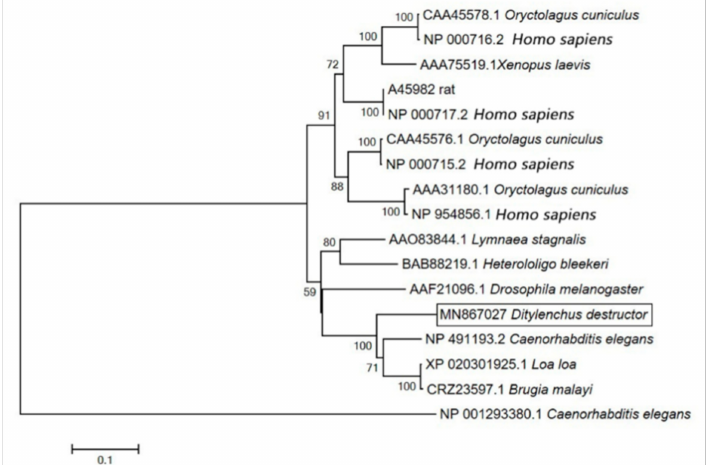
Figure 2. Molecular phylogenetic analysis of DdCa v β via the neighbor-joining method. The species that were used in phylogenetic tree construction are summarized in Table 1. The phylogram was constructed based on the amino acid sequences of 16 Ca v β proteins using MEGA 7.0. The numbers below the branches indicate the bootstrap